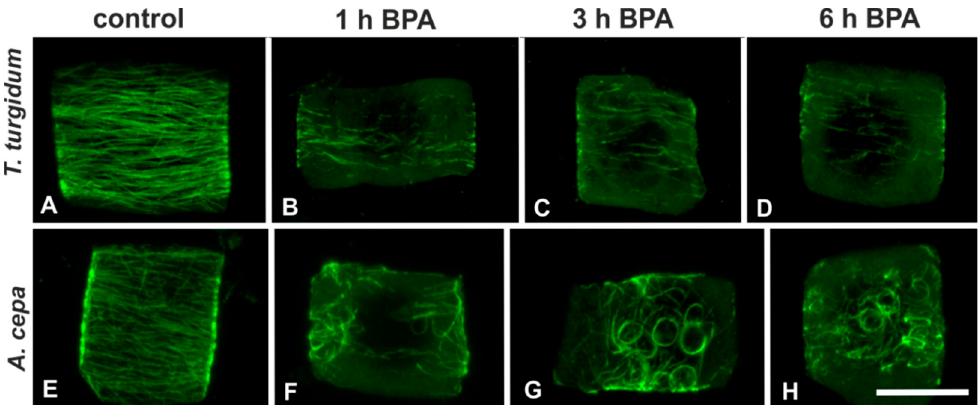
Figure 1. Tubulin immunolocalization in interphase root cells of the two plant species studied, either untreated or bisphenol A (BPA)-treated (as depicted), at a single cortical confocal laser scanning microscope (CLSM) section ( A , B , E , G ) or a maximum projection of serial sections ( C , D , F , H ). The plant species and treatment regime are similarly noted in all the following figures. Scale bar: 10 μ m.